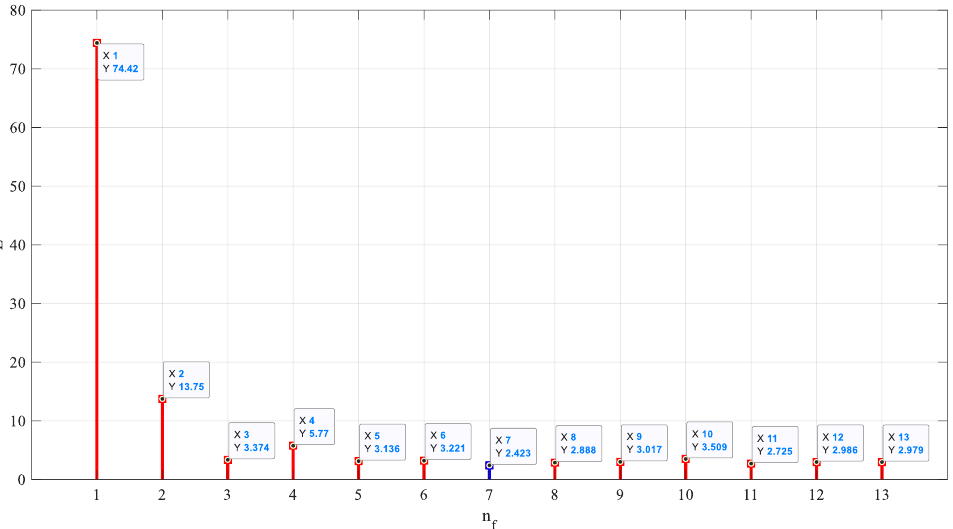
Figure 8. Calculated cost function in the PSO algorithm according to the number of selected charac- teristics.